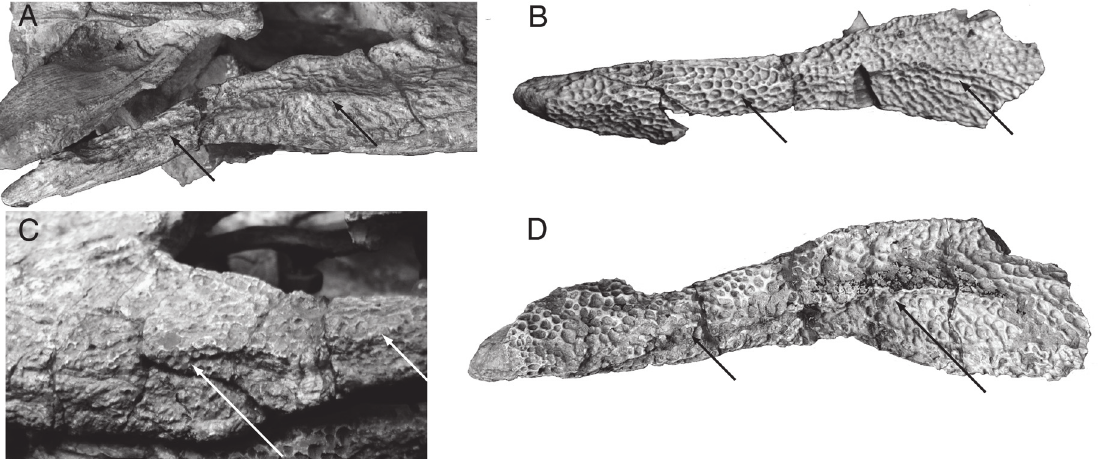
Fig 10. Jugal morphology in Paralligatoridae. A , Shamosuchus ulanicus (= Paralligator gradilifrons ) (PIN 3140-502), right side; B , S . tersus (= Paralligator gradilifrons ) (PIN 3141-501), right side; C , S . (= Paralligator ) gradilifrons (PIN 554-1, holotype), left side; D , S . ancestralis (= Paralligator gradilifrons ) (PIN 551-29/7), right